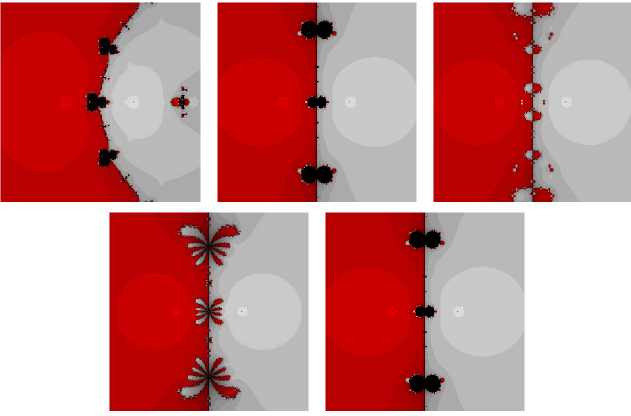
Figure 7. The basins of attraction for OM 4 , LM 4 , SSM 4 , ZM 4 and SM 4 , from left to right and top to bottom, respectively in Problem 4.